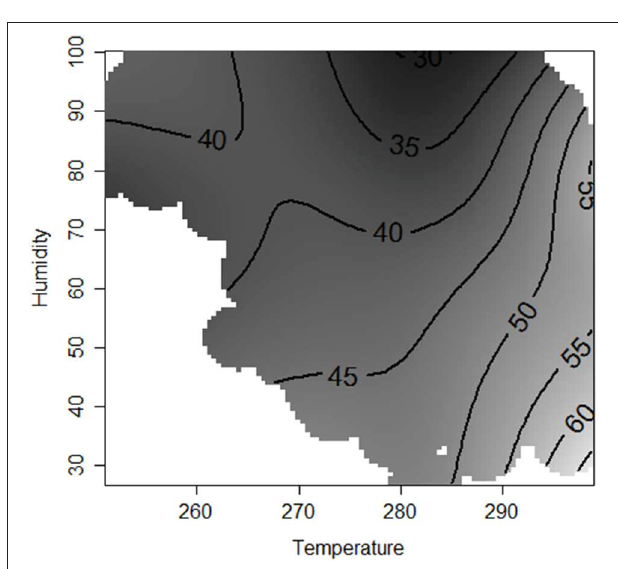
FIGURE 9 | Effect of interactions of air temperature*relative humidity upon expected ambient O 3 concentration, BKR